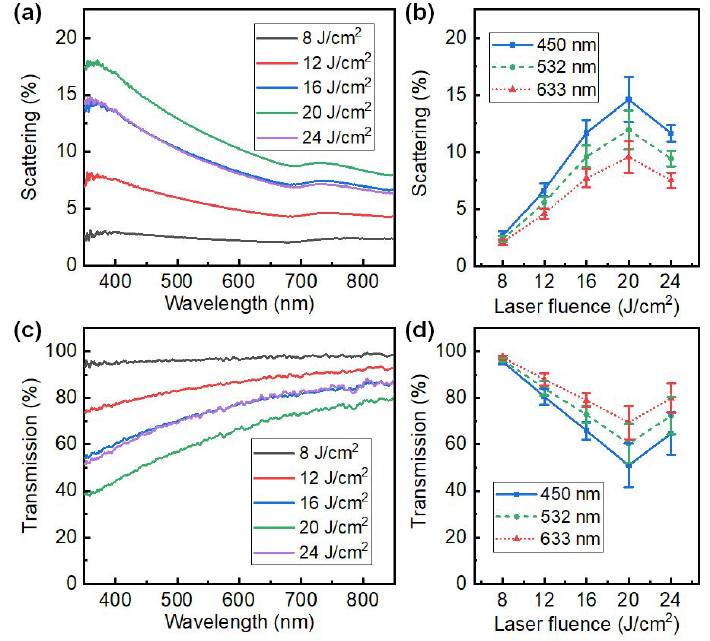
Figure 8. Optical properties of LTNS films. ( a ) Forward scattering spectra and ( c ) transmission spectra with a set of laser fluencies. ( b ) Forward scattering coefficient and ( d ) transmission coefficient as a function of laser fluencies at wavelengths of 450, 532, and 633 nm.